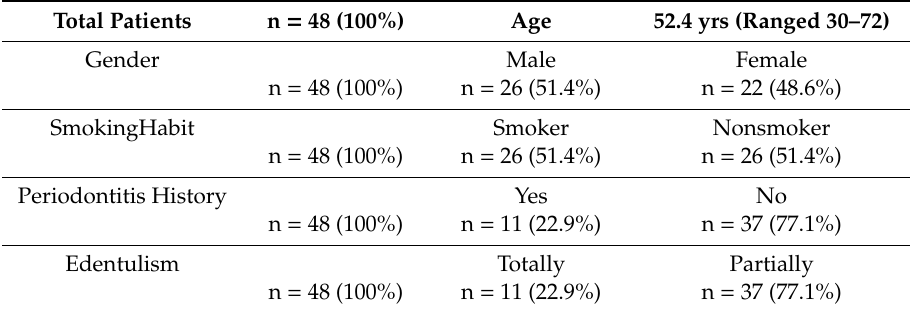
Table 1. Description of the age and total distribution of the sample, according to the following parameters: gender, smoking habit, periodontitis history, and type of edentulism Total Patients